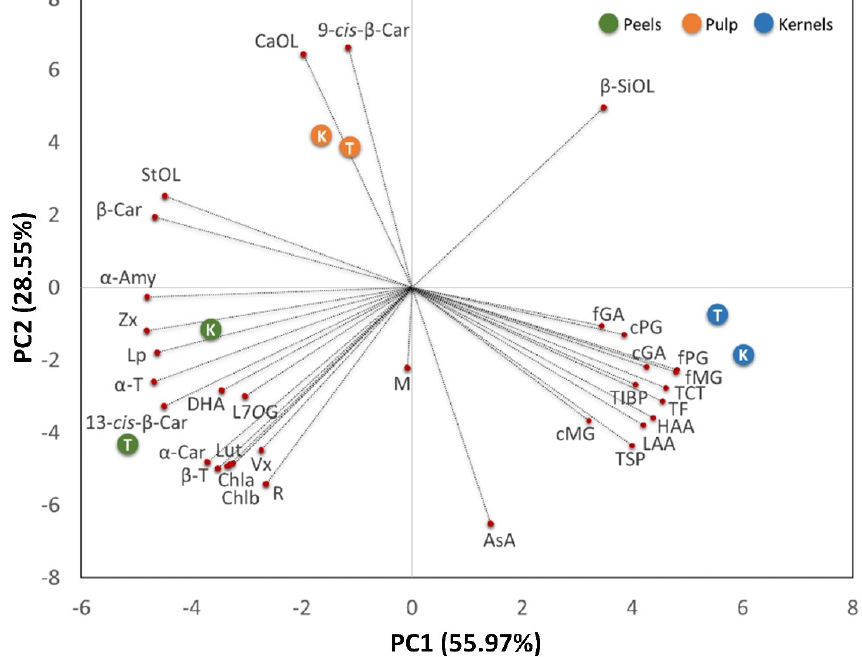
Figure 5. Principal component analysis (PCA) biplot PC1 vs. PC2 of total soluble phenolics (TSP), total insoluble bound phenolics (TIBP), total flavonoids (TF), total condensed tannins (TCT), free gallic acid (fGA), free methyl gallate (fMG), free propyl gallate (fPG), conjugated gallic acid (cGA),